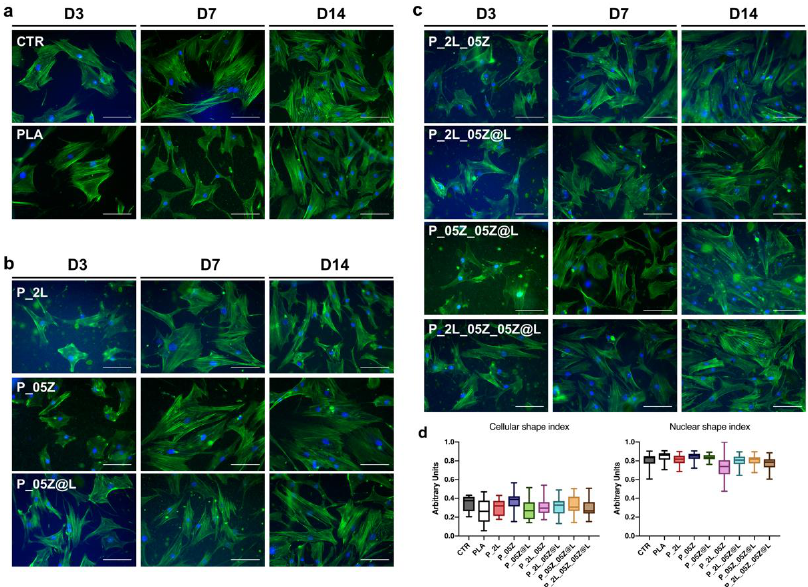
Figure 9. hASCs morphology on PLA films. F-actin fibers of hASCs cultured on ( a ) control and PLA, ( b ) PLA binary (P_2L, P_05Z, P_05Z@L) and ( c ) PLA ternary (P_2L_05Z, P-2L_05Z@L, P05Z_05Z@L) and quaternary (P_2L_05Z_05Z@L) films. F-actin (Alexa-fluor-488 Phalloidin, green), Nuclei (4′,6-diamidino-2-phenylindole, DAPI, blue), Scale bar = 100 m. ( d ) Cell shape index, and nuclear shape index. Cyto-morphometric measurements in Figure 9d refer to stem cells at day 7 in culture, however, these results are representative of hASCs at each time in culture; * p < 0.05, ** p < 0.01, *** p < 0.001.